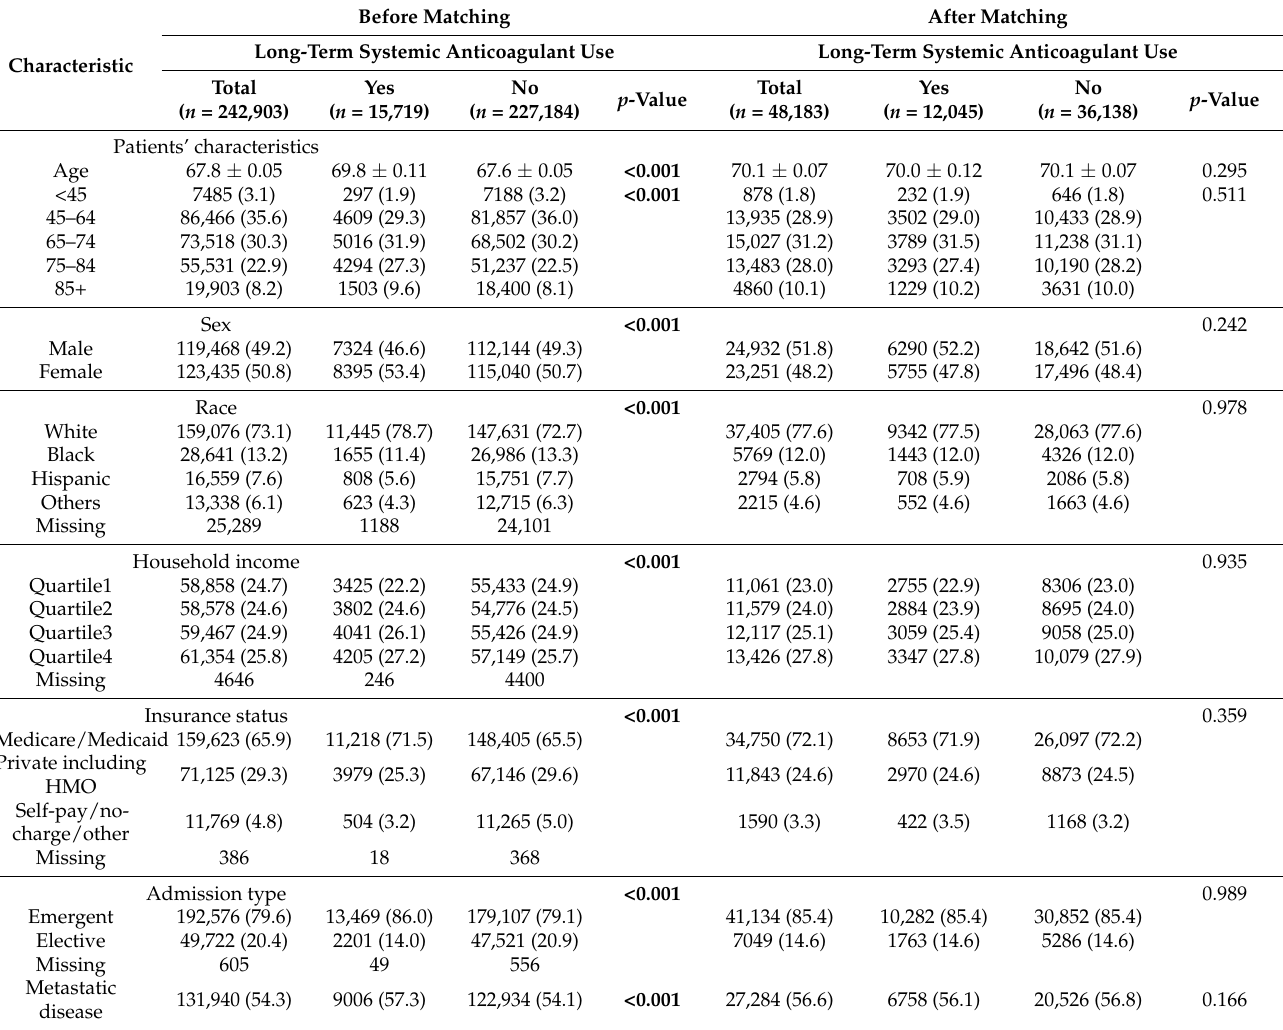
Table 1. Characteristics of hospitalized pancreatic cancer patients with or without long-term systemic anticoagulant